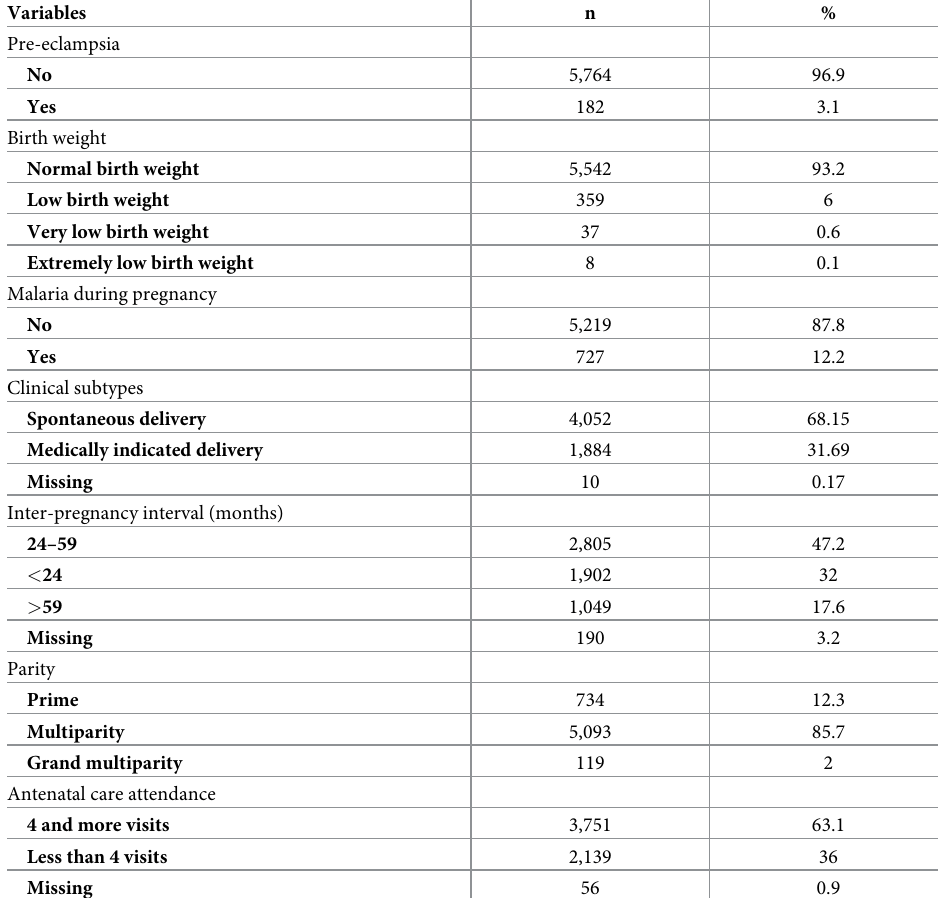
Table 2. Clinical characteristics of mothers with consecutive deliveries at KCMC (N = 5,946).